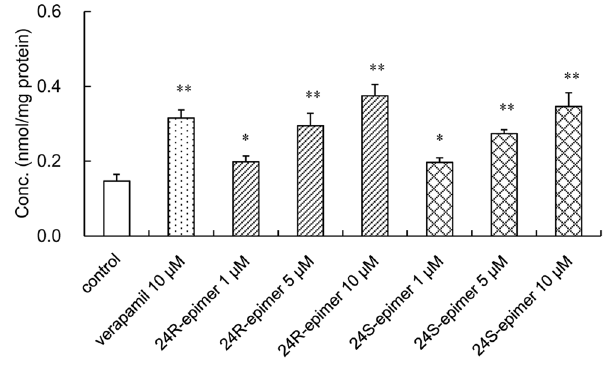
Figure 5. Effects of 24R-epimer and 24S-epimer on the accumulation of rhodamine 123 in Caco-2 cells. Cells were the presence of 5 m M rhodamine 123. Data are the mean 6 S.E. of three independent experiments. * p , 0.05 versus control; ** p , 0.01 versus